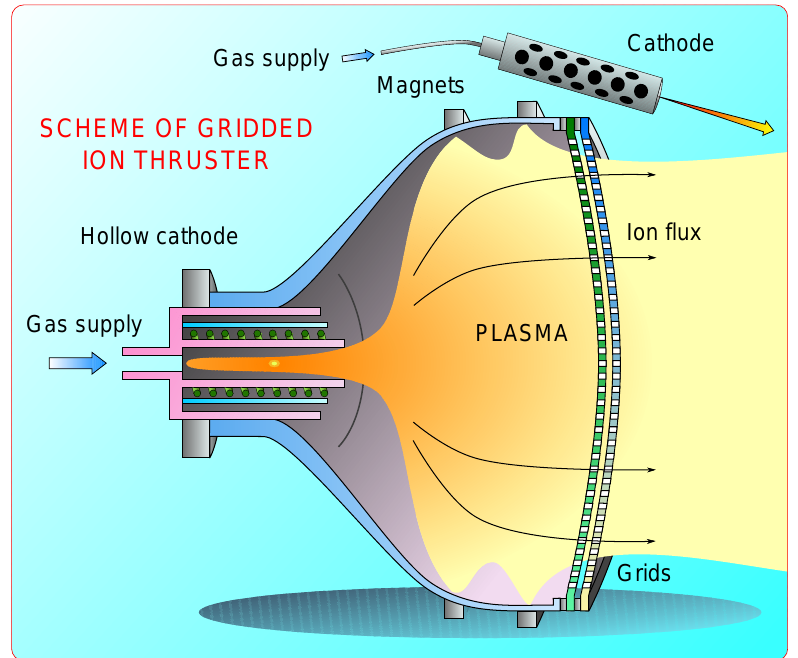
Figure 3. Gridded ion thruster. The gridded ion thruster is a second promising candidate for powering future spacecraft. Integration of electric propulsion thrusters into satellites represents an even more complex task due to the possible interactions of the thruster and plasma jets with sub-systems integrated within the satellite.